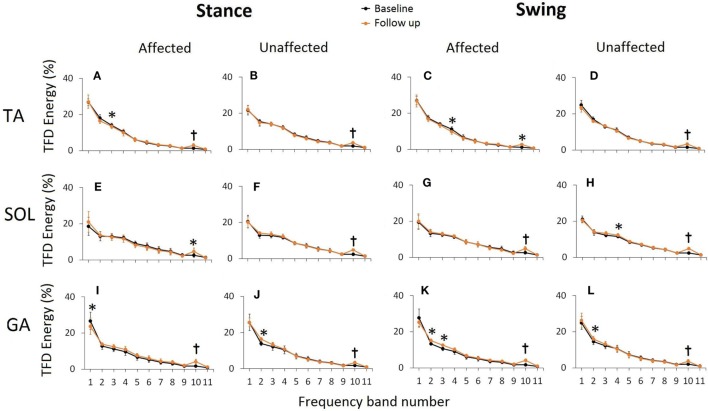
Time frequency distribution (TFD) energies associated with 11 predefined frequency bands during normalized stance and swing at baseline and follow-up for TA (A–D), SOL (E–H), and GA (I–L). TFD energy in each band is presented as a percentage of total TFD energy during a normalized gait averaged across six stroke participants. Error bars represent ±SD. Significant differences are shown as *(p < 0.05) and t(p < 0.005). The frequencies associated with the predefined bands are 1: 25–50 Hz, 2: 51–75 Hz, 3: 76–100 Hz, 4: 101–125 Hz, 5: 126–150 Hz, 6: 151–175 Hz, 7: 176–200 Hz, 8: 201–225 Hz, 9: 226–250 Hz, 10: 251–275 Hz, and 11: 276–300 Hz.